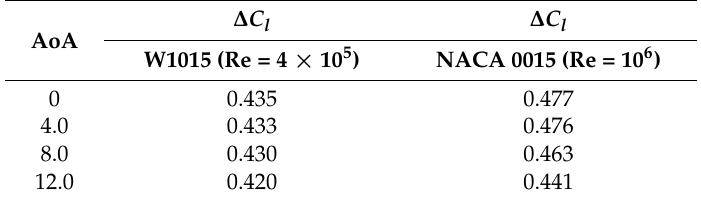
Table 7. The Increment in the value of the lift coefficient due to a flap deflection of 10°. ∆ C l AoA